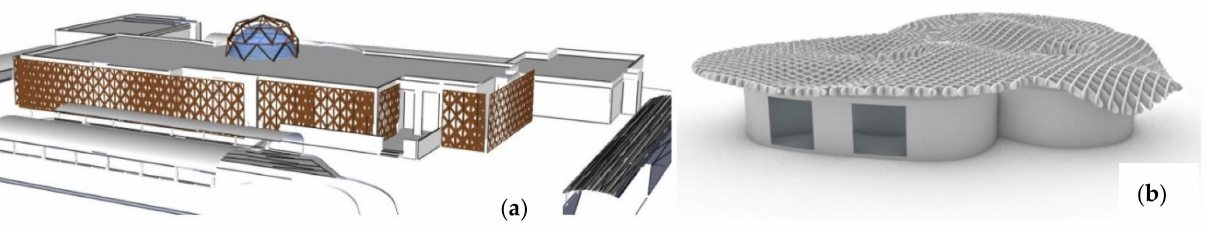
Figure 22. ( a ) Retrofitted model, ( b ) new building design